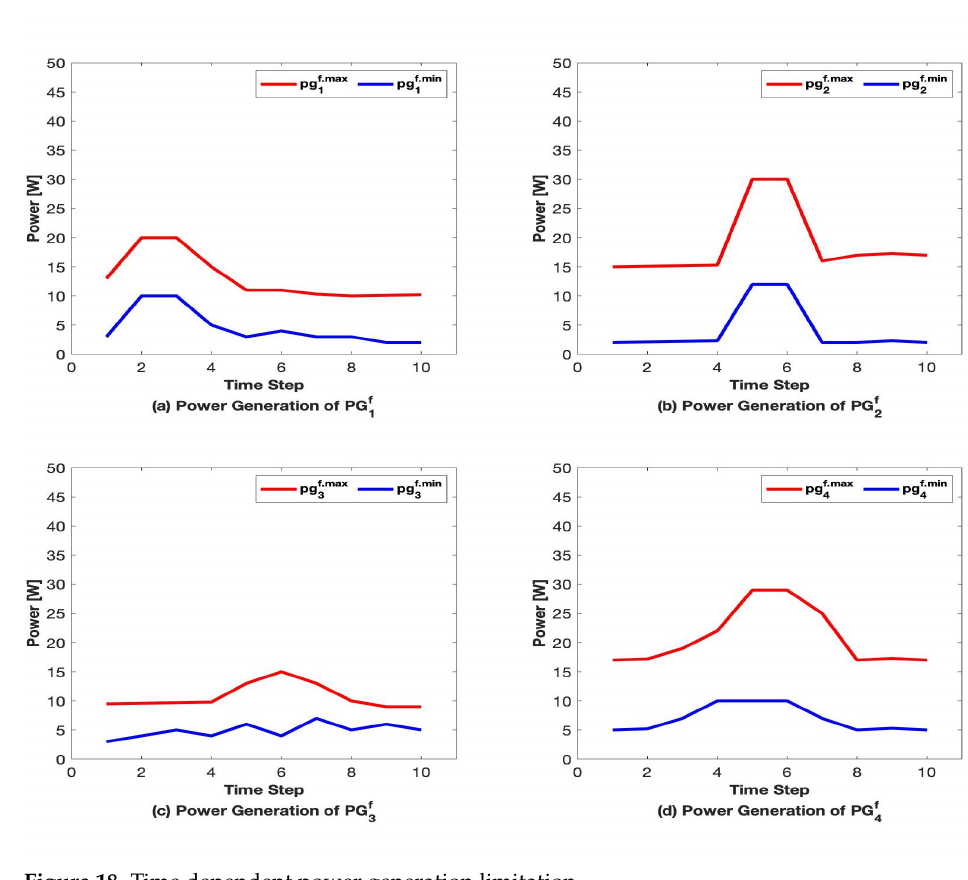
Figure 18. Time dependent power generation limitation.